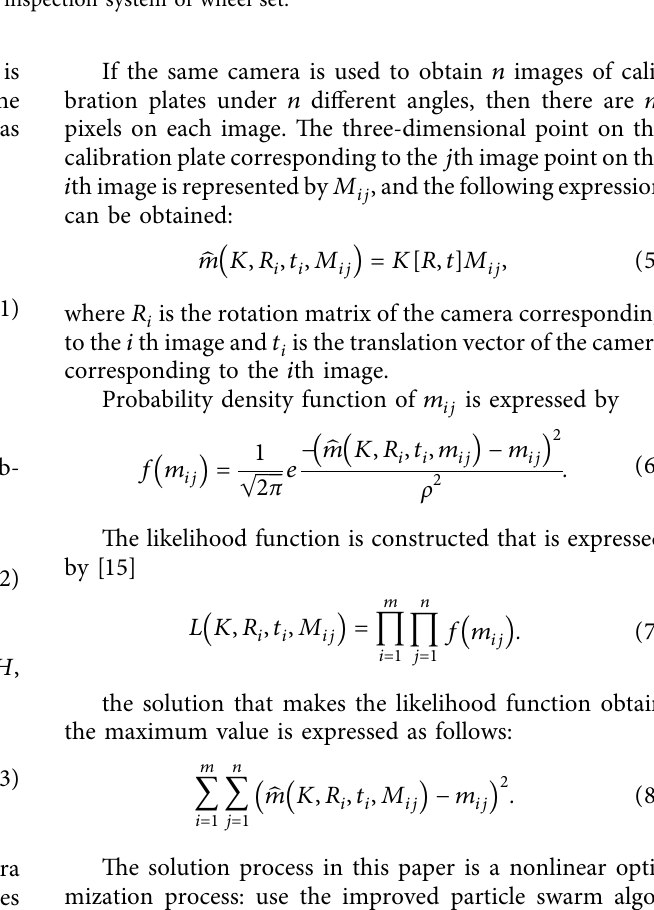
Figure 1: Diagram of inspection system of wheel